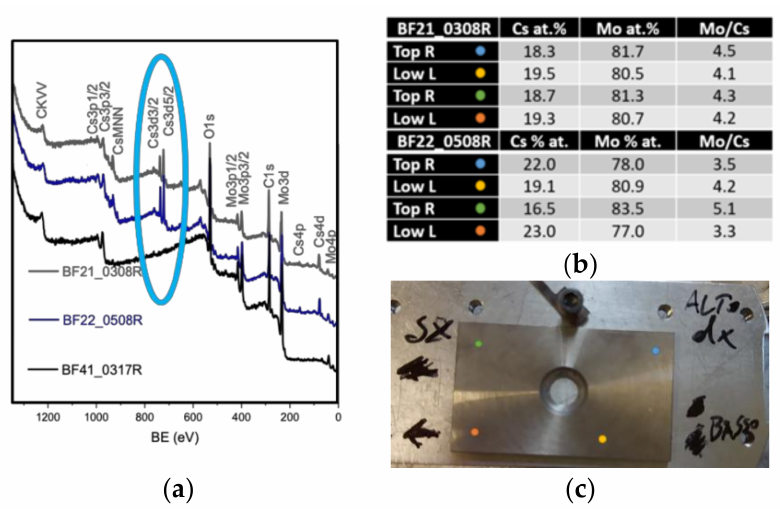
Figure 11. XPS analysis results on BF21, BF22 and BF41. ( a ) XPS surveys, ( b ) chemical composition for samples BF21 and BF22, ( c ) example of BF probe orientation and analyzed